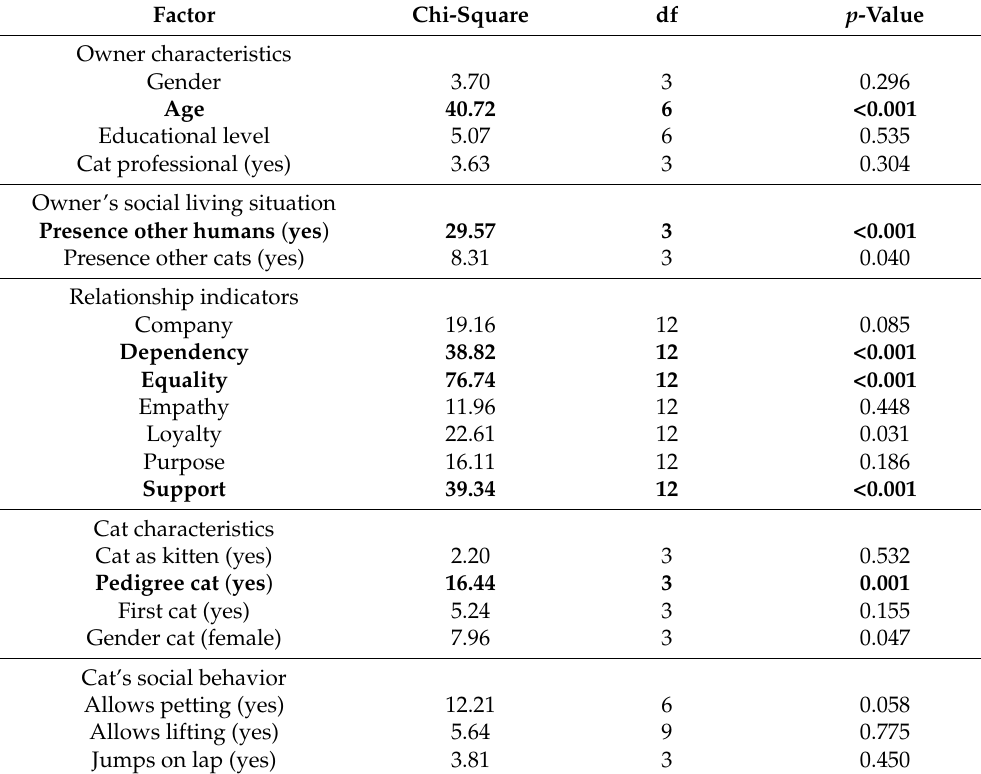
Table 2. Likelihood ratio